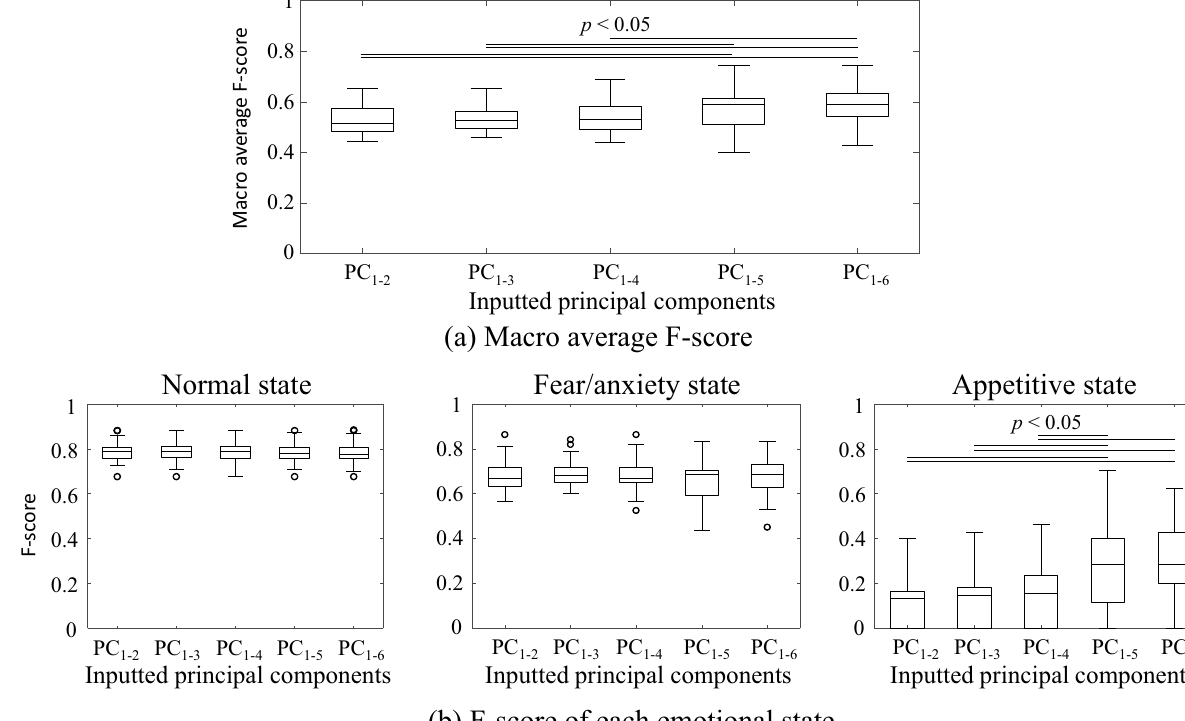
Figure 8. F-scores obtained from the linear discriminant analysis. PC 1− N denotes that the first through the N th PCs were used for discrimination. ( a ) Boxplot of macro average F-scores for all emotional states. ( b ) F-scores of each emotional state. In the macro average and appetitive states, the F-scores significantly increases with the PC used for